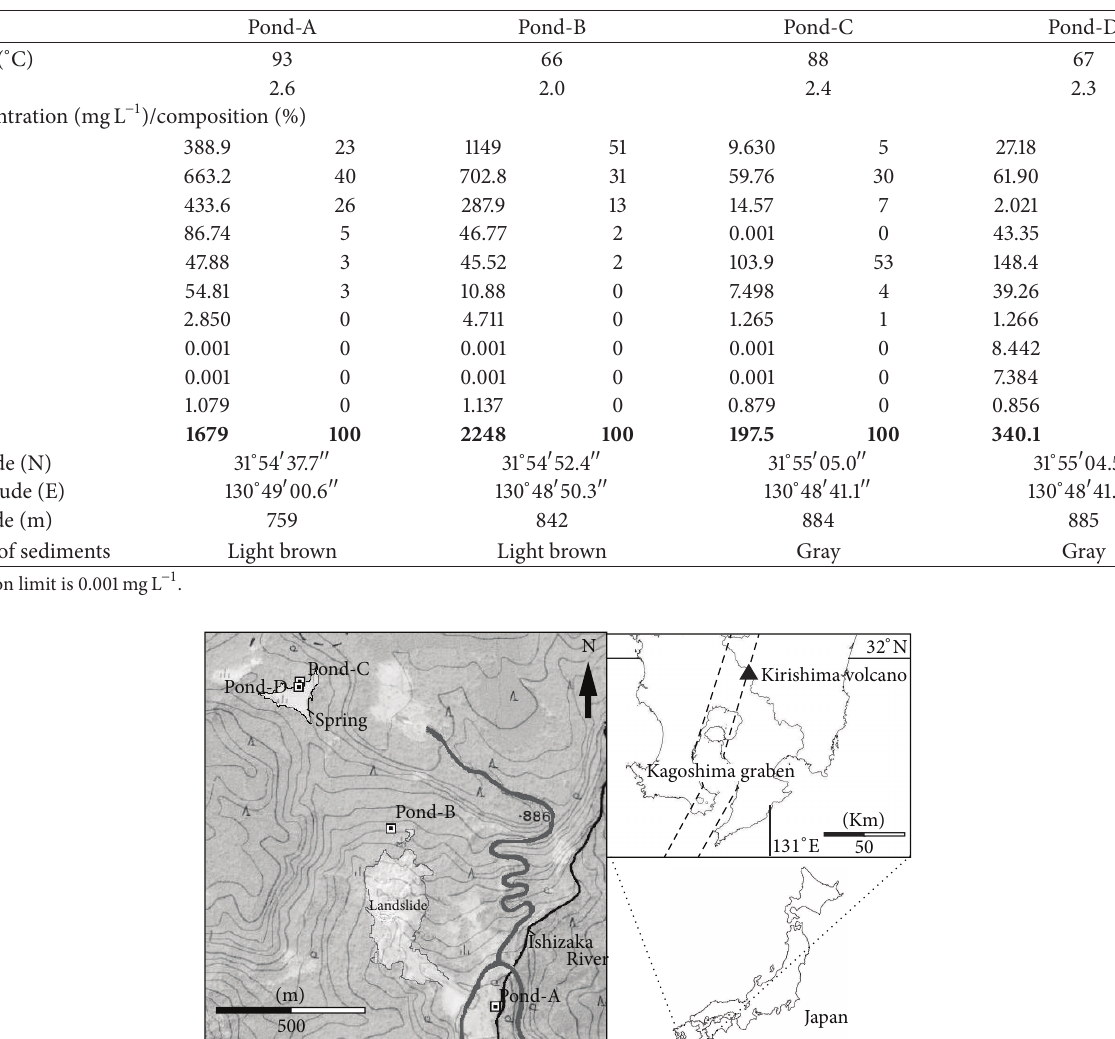
Table 1: Characteristics of sampling sites and ponds.